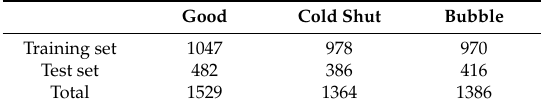
Table 5. Configuration of the dataset for constructing the quality-prediction model.